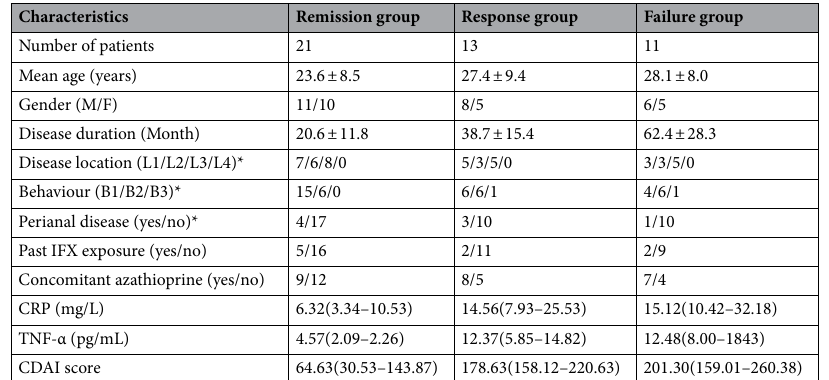
Table 2. Clinical characteristics of CD patients with IFX treatment. *Montreal Classification. The data are presented as the mean ± SD or medians (1/4–3/4 quarters). Patients with isolated upper disease (L4) were